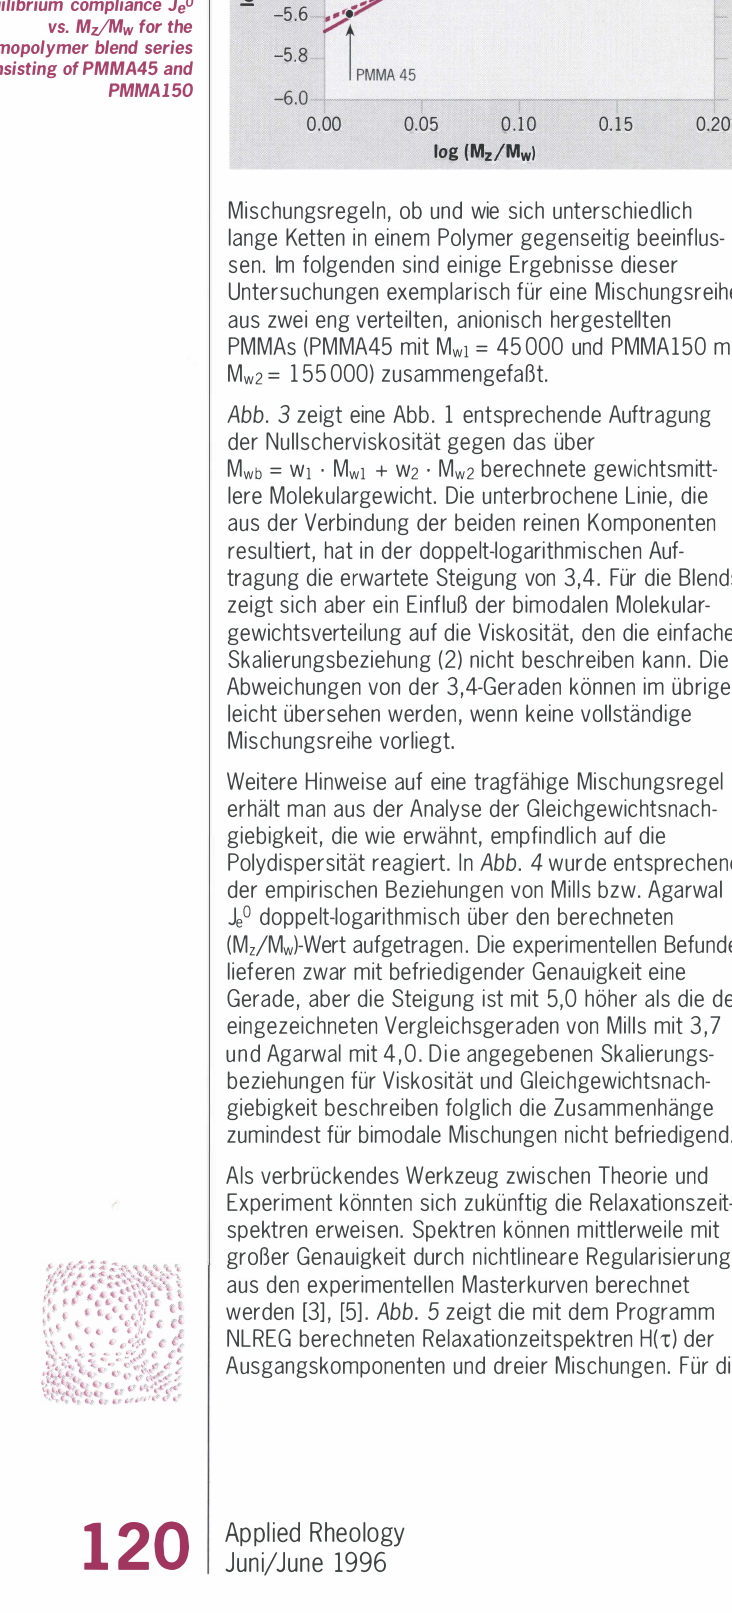
Fig. 4: Auftragung der Gleichgewichtsnachgiebigkei t Jeo gegen Mz!Mw im doppelt-logarithmischen Mallstab fiir die Homopolymer-Biendreihe aus PMMA45 und PMMA150 Fig.4. Log-log plot of the equilibrium compliance JeD vs. Mz!Mw for the homopolymer blend series consisting of PMMA45